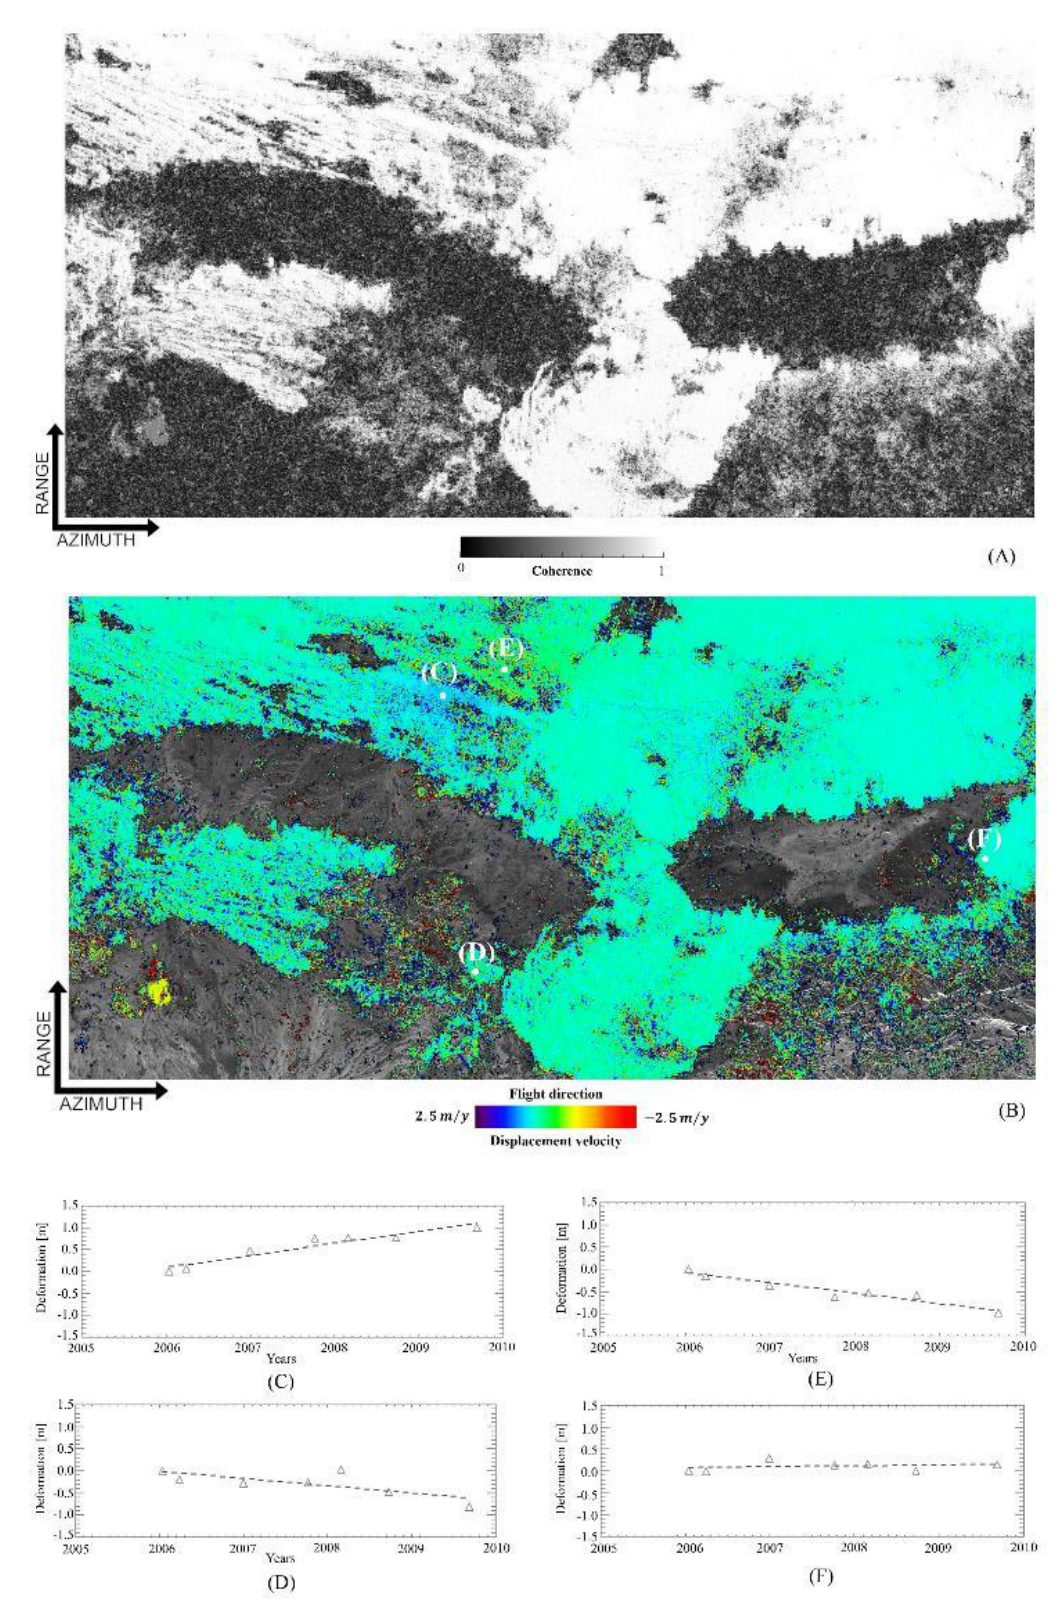
Figure 16. ( A ) Coherence map of MAI interferograms. ( B ) Mean deformation velocity map of the Afar Figure 16. (A) Coherence map of MAI interferograms. (B) Mean deformation velocity map of the Afar area superimposed on a SAR amplitude image of the area. ( C ) Displacement time-series related to the area superimposed on a SAR amplitude image of the area. (C) Displacement time-series related to the major fault area, ( D , E ) related to the medium-magnitude fault area and ( F ) related to the low-magnitude major fault area, (D,E) related to the medium-magnitude fault area and (F) related to the low- deformation magnitude deformation area.